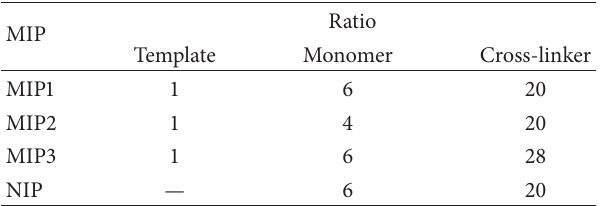
Table 1: Ratios of template to functional monomer to cross-linker used in MIPs and